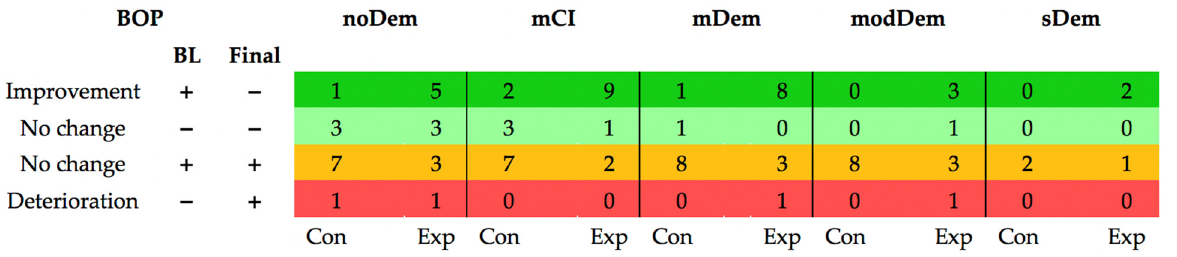
Figure 4. Changes in bleeding on probing (BOP) over time, separated by mini mental state examination (MMSE) group and subgroup (Con: control group; Exp: experimental group) (green: improvement; light-green and orange: no change; red: deterioration) (Dementia groups—noDem: no dementia; mCI: mild cognitive impairment; mDem: mild dementia; modDem: moderate dementia; sDem: severe dementia). (BL: Baseline) (colors green to red symbolize the deterioration in BOP).